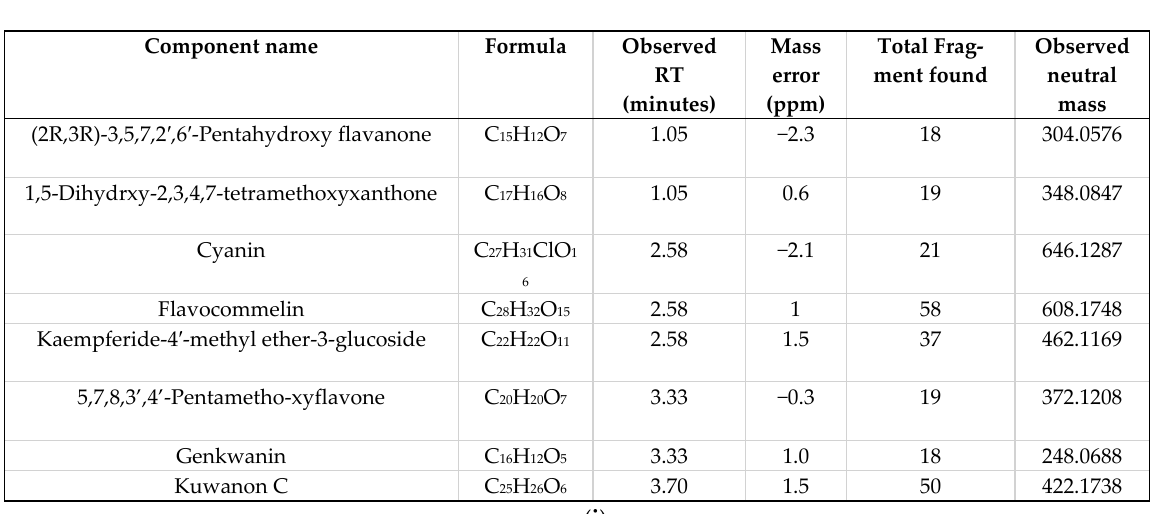
Figure 1. Effects of Cr-ME on NO production in macrophages. ( a – d ) The levels of NO production in RAW264.7 cells stimulated with ( a , b ) or without ( c , d ) LPS (1 μ g/mL), pam3CSK (10 μ g/mL) or poly(I:C) (200 μ g/mL) in the presence or absence of Cr-ME ( a , c ) or L-NAME( b , d ) for 24 h were measured by Griess assay. ( e , f ) The viabilities of RAW264.7 cells treated with the indicated doses of Cr-ME ( e ) or L-NAME ( f ) for 24 h were determined using the MTT assay. ( g ) Treatment with